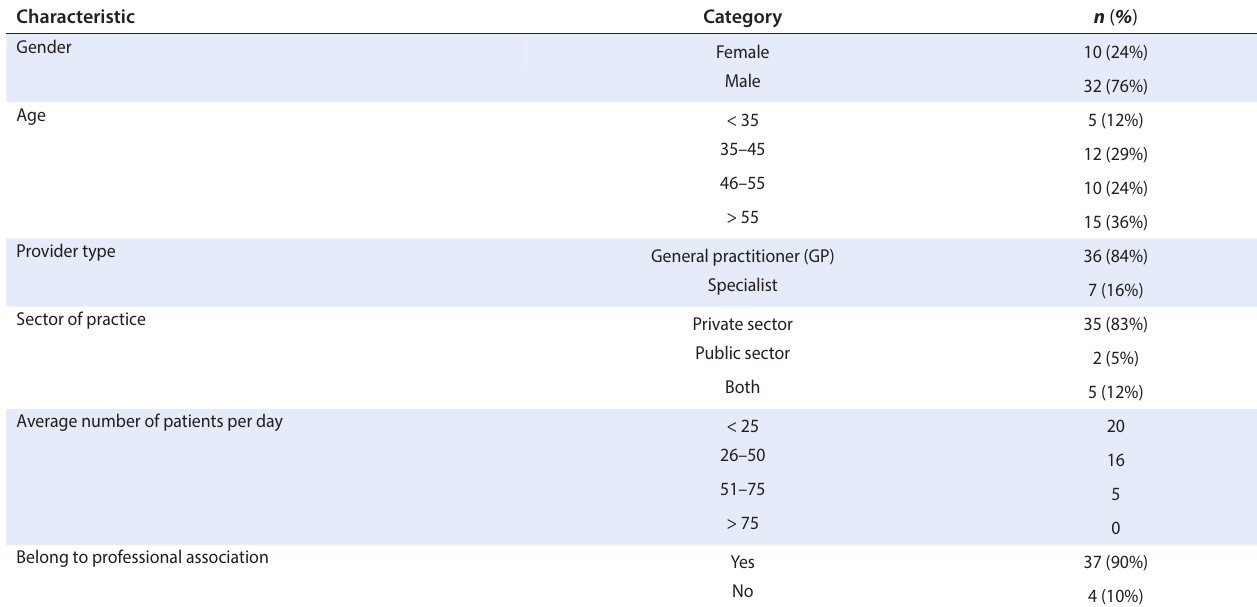
Table 1: Demographic characteristics of respondents Characteristic